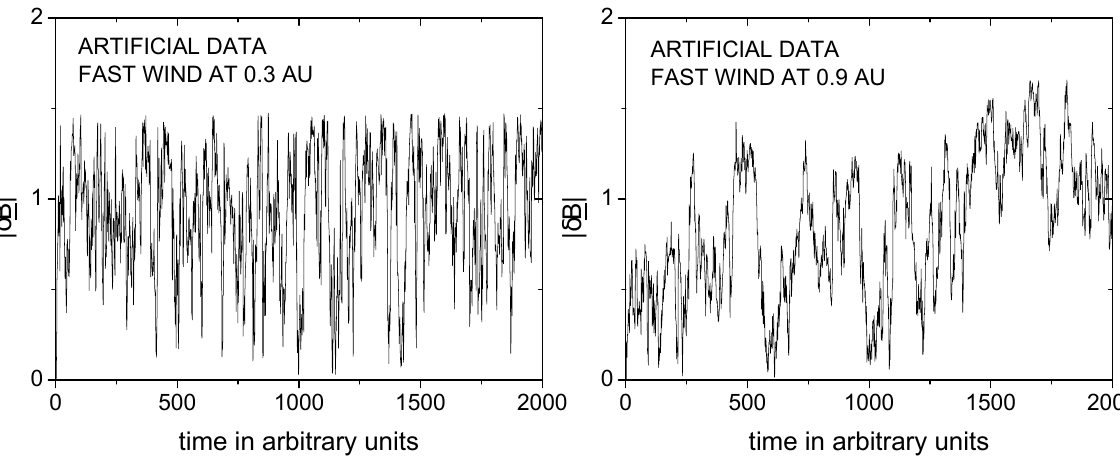
Fig. 14. Vector displacement versus time as measured from artificial data referring to a fast wind at 0.3AU on the left panel and at 0.9AU on the right panel. These plots should be compared to the top panels of Figs. 6 and 7, respectively.